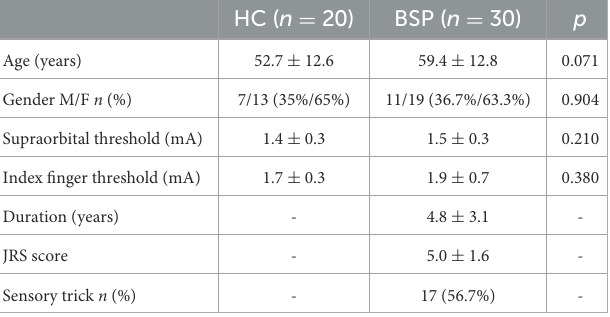
TABLE 1 Demographic and clinical characteristics of the HC and BSP groups.